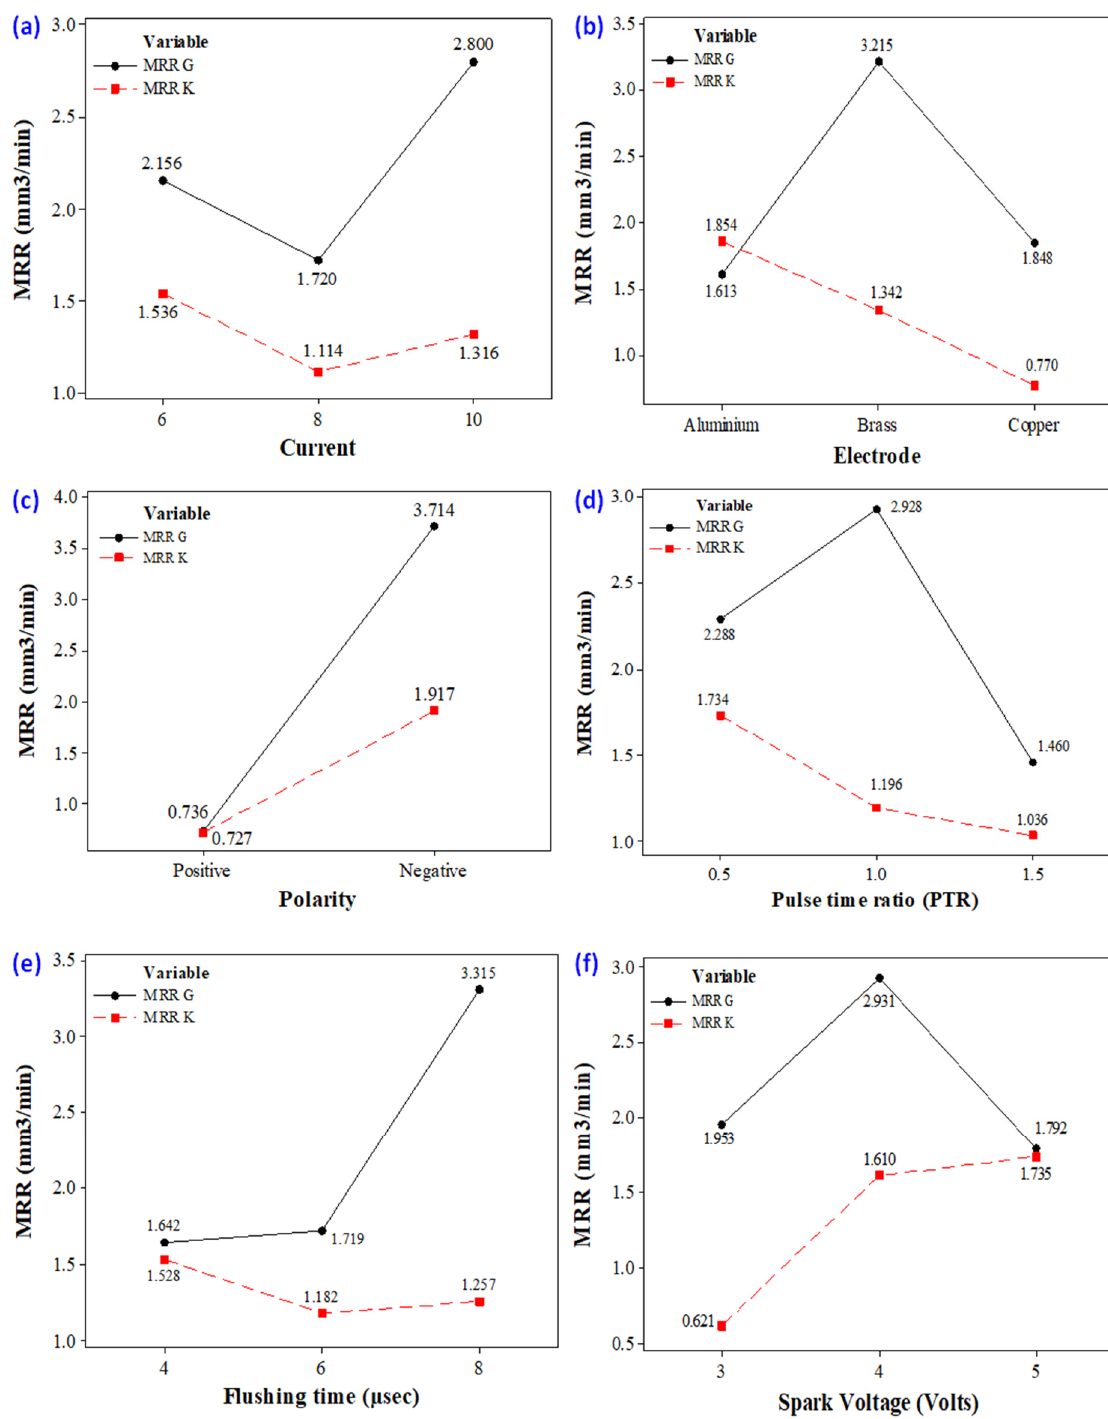
Figure 6. Parametric plots ( a ) discharge current vs. MRR ( b ) electrode vs. MRR ( c ) polarity vs. MRR ( d ) pulse–time ratio vs. MRR ( e ) flushing time vs. MRR ( f ) spark voltage vs. MRR.